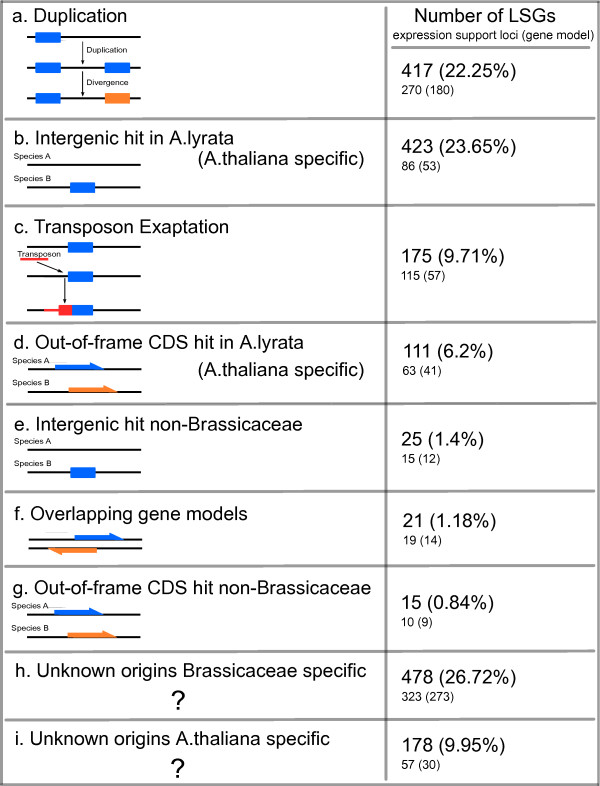
Summary of evidence for evolutionary origins of Arabidopsis thaliana lineage-specific genes. The number of LSGs that fit each evolutionary scenario tested, plus the number of LSGs without elucidated origins. Support for gene model expression provided by an EST or cDNA consistent with the of gene model (as listed by TAIR). Support of expression at the locus provided by EST, cDNA or microarray probeset (TAIR and Ath1 affymetrix microarray).